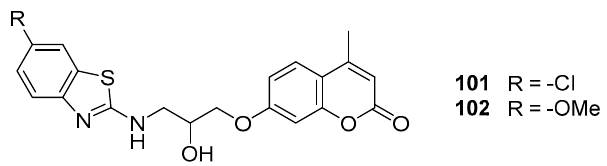
Figure 35. Anti-inflammatory 7-substituted coumarins proposed by Srivastava [146].